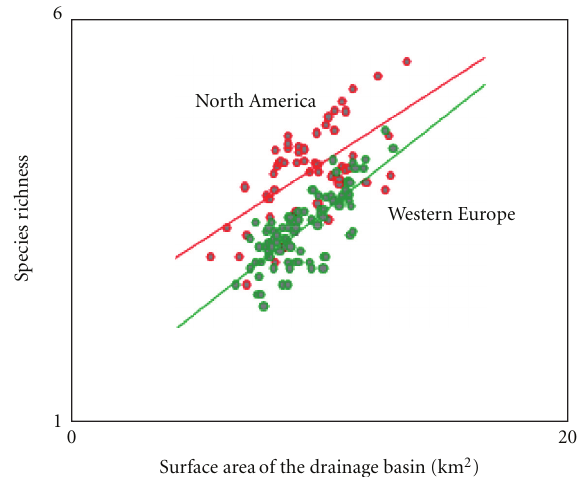
Figure 4: Plot of fish species richness as a function of the surface area of drainage basins for West European and North American rivers. Variables expressed in logarithmic values (Ln): redrawn from Oberdor ff et al.